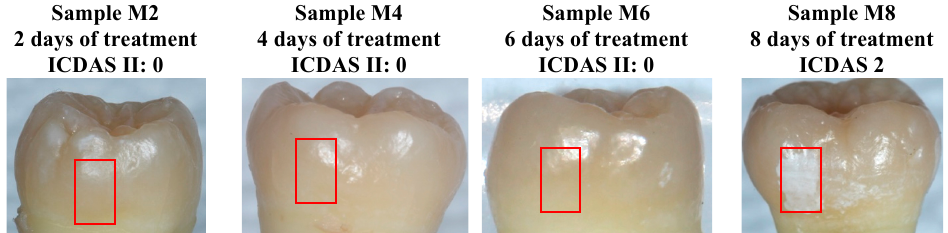
Figure 9. Optical images of samples M2, M4, M6, and M8 after cariogenic biofilm exposure. The red rectangles show the regions of exposure on the teeth. Only sample M8 (8 days of cariogenic biofilm exposure) developed visible caries.